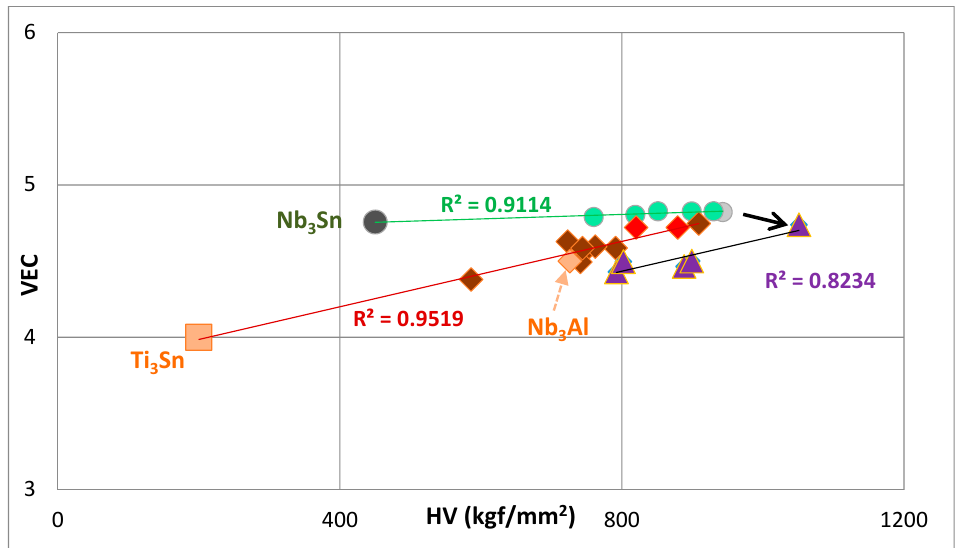
Figure 8. VEC versus hardness (HV) of A15–Nb 3 X and Ti 3 Sn (light orange square). Green circles represent Nb 3 Sn (dark green), Nb 3 (Sn,Si) (very light green), (Nb,Hf) 3 (Sn,Si) and (Nb,Hf,Cr) 3 (Sn,Si). Dark red diamonds represent (Nb,Ti) 3 (Sn,Si), (Nb,Hf) 3 (Sn,Si), (Nb,Cr,Hf) 3 (Sn,Si), (Nb, Ti,Cr,Hf) 3 (Sn,Si), (Nb,Ti,Fe) 3 (Sn,Si), (Nb,Hf) 3 (Sn,Si,Al) (red diamonds); the light orange diamond represents Nb 3 Al, and purple triangles represent Nb 3 (Sn,Si,Al), (Nb,Ti,Hf) 3 (Sn,Si,Al) and (Nb,Ti,Hf,Cr) 3 (Sn,Si,Al).